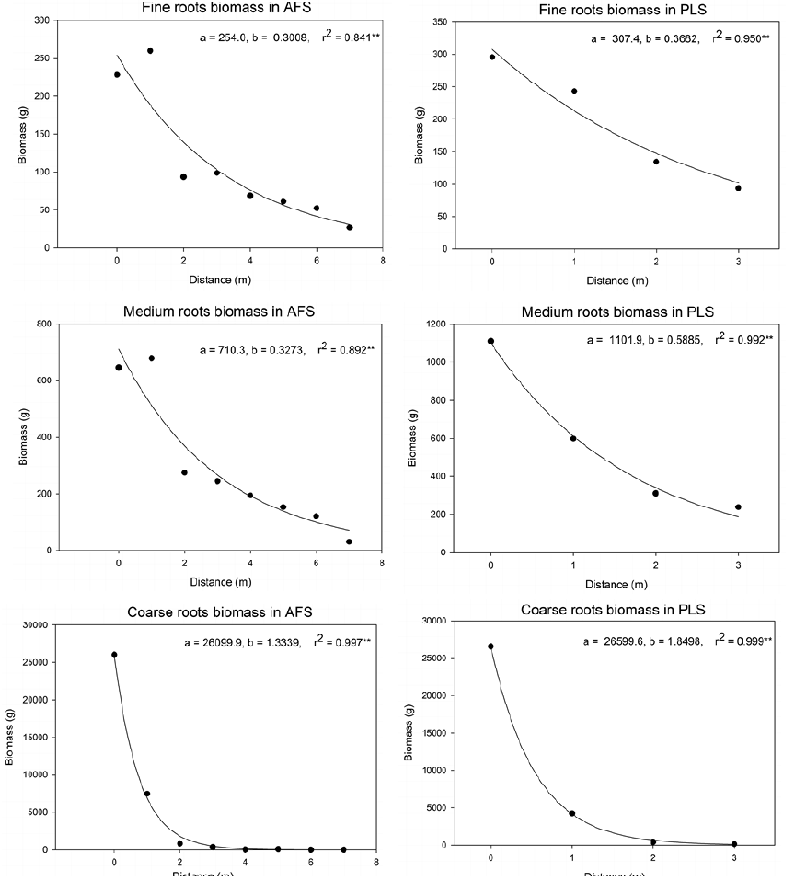
Fig. 5. Charts displaying biomass regression curve (exponential decay) along with corresponding intercept and slope values in AFS and PLS (FRS). X axis: distance from the tree and Y axis: root